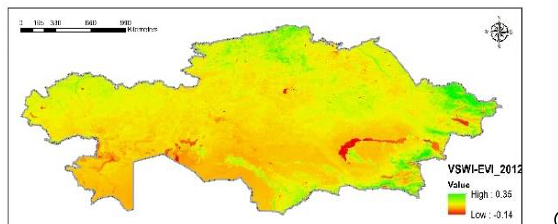
Figure 2. Remote sensing of drought monitoring in a severe